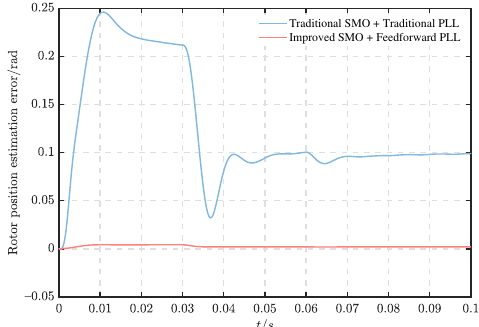
Figure 15. Rotor position observation errors (dynamic).